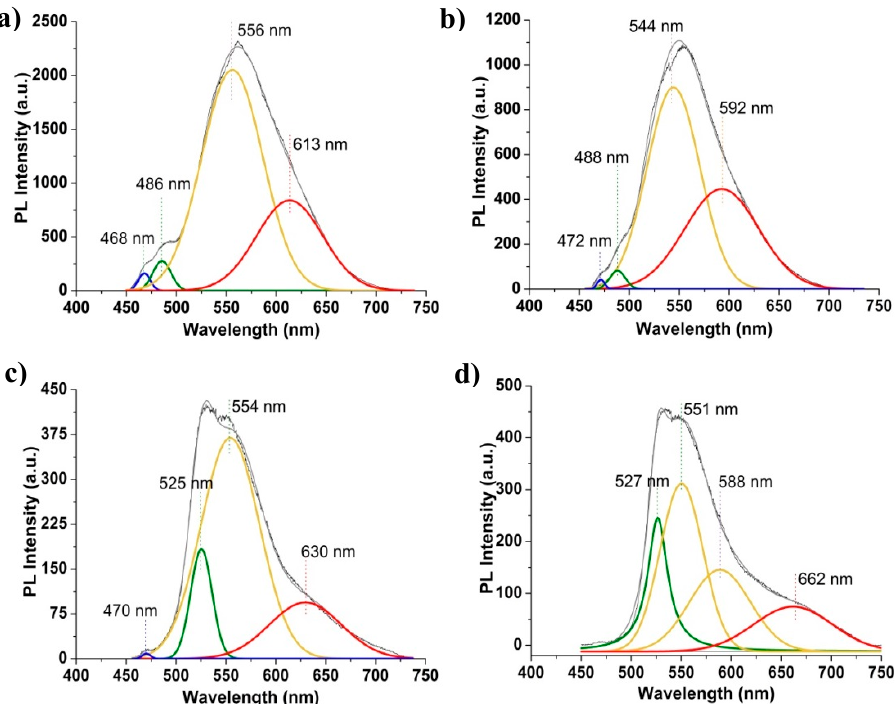
Figure 5. PL spectra of AgCdS-T photocatalysts: ( a ) T = 90 °C; ( b ) T = 120 °C; ( c ) T = 150 °C; and ( d ) T = 190 °C.